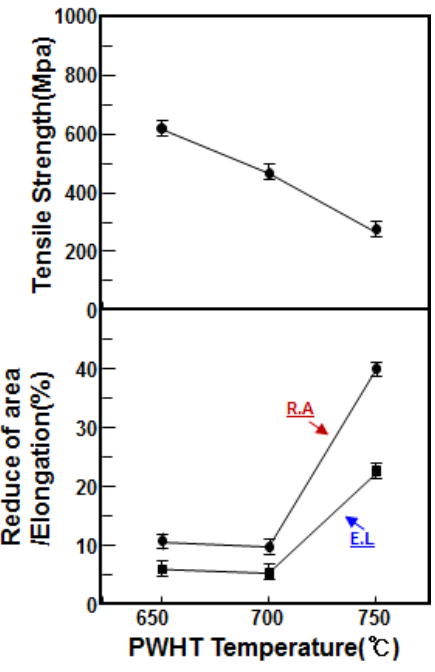
Figure 2. Results of PWHT cracking test at various temperatures.